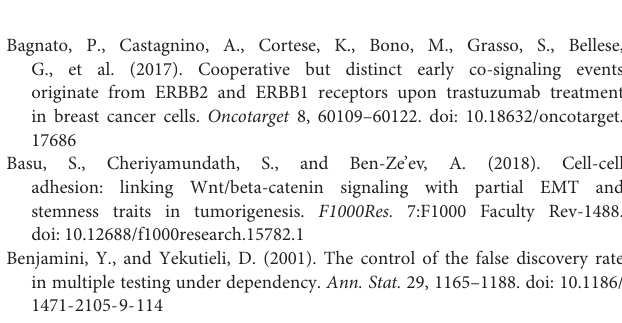
TABLE S5 | Bridgeness values for cancer and synaptic p140Cap networks. TABLE S6 | Disease overlap for cancer and synaptic p140Cap